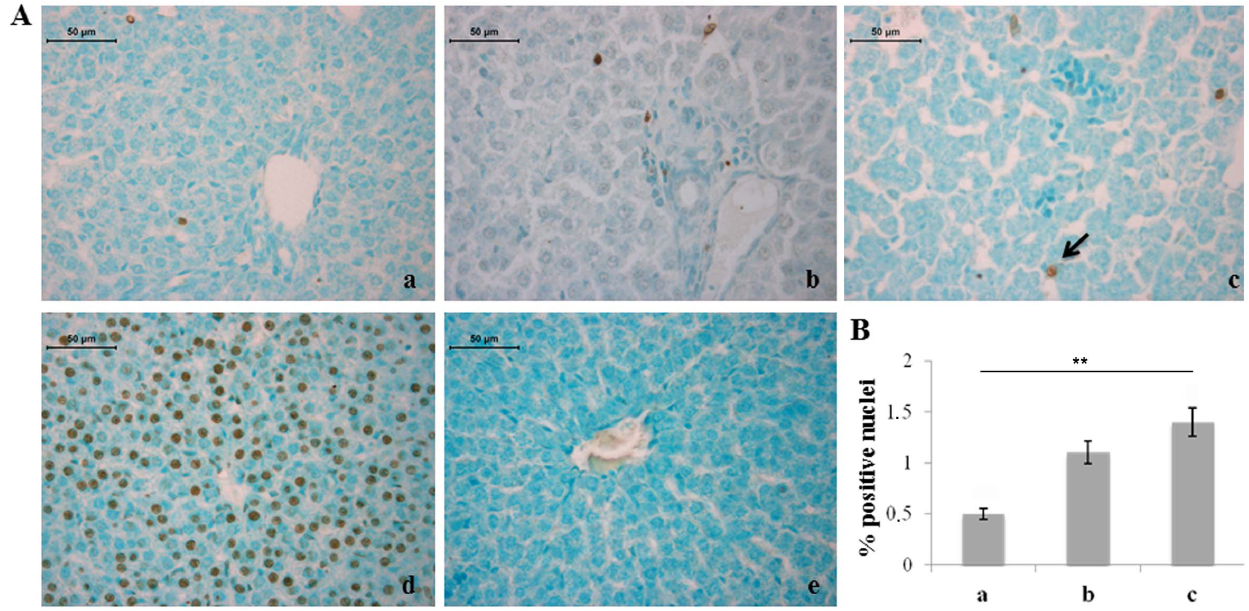
Figure 2. Severe hyperoxia increases hepatocyte apoptosis. A) TUNEL detection of apoptotic nuclei (arrow) in neonatal rat livers exposed to moderate and severe hyperoxia. a) ambient air; b) 60% hyperoxia; c) 95% hyperoxia; d) positive control; e) negative control. Scale bar: 50 m m, magnification 40x. B) Graphic representation of the percentage of TUNEL positive nuclei ( 6 SD) determined by direct visual counting of ten fields for each of three slides per sample. **=p ,